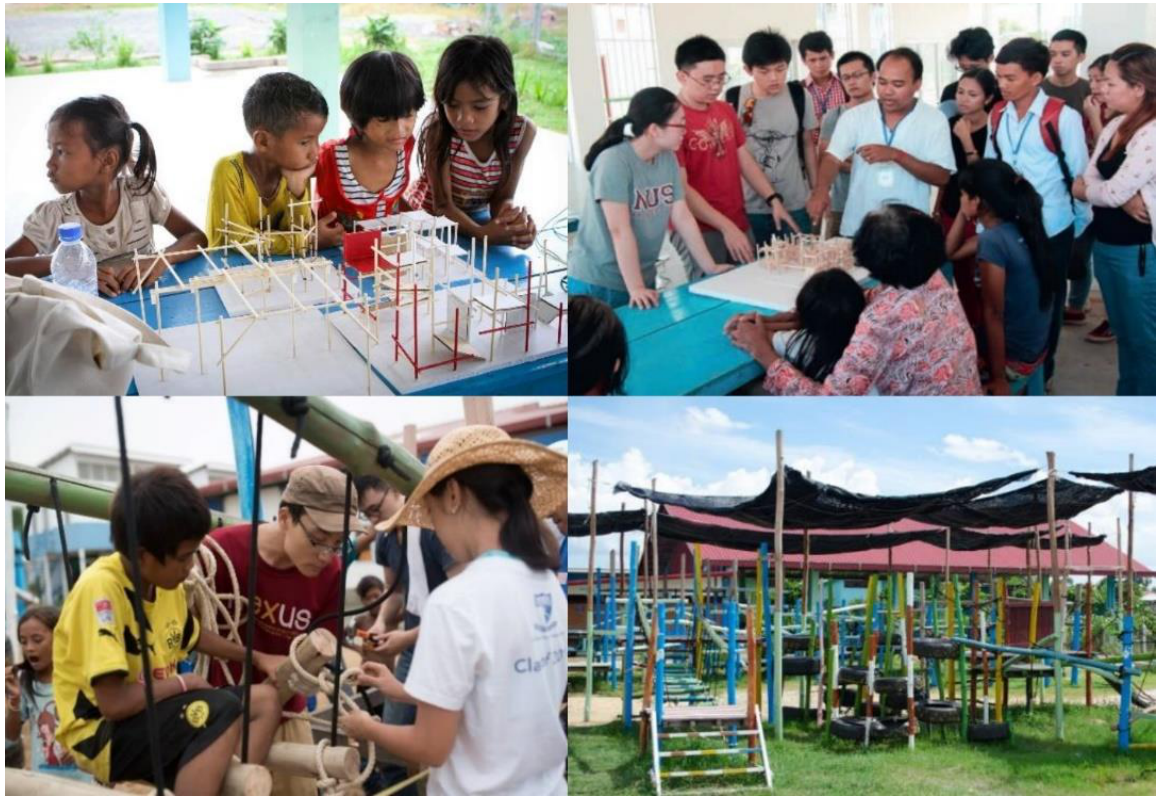
Figure 4. Community’s playground and its construction process. Source: NUS-Tan Beng Kiang.